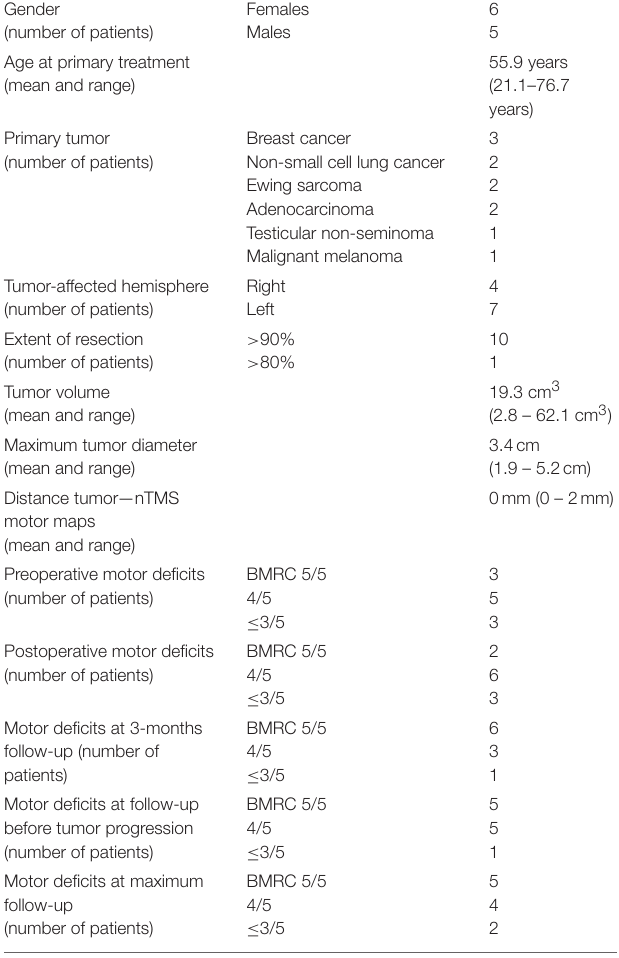
TABLE 1 | Patient characteristics. Gender (number of